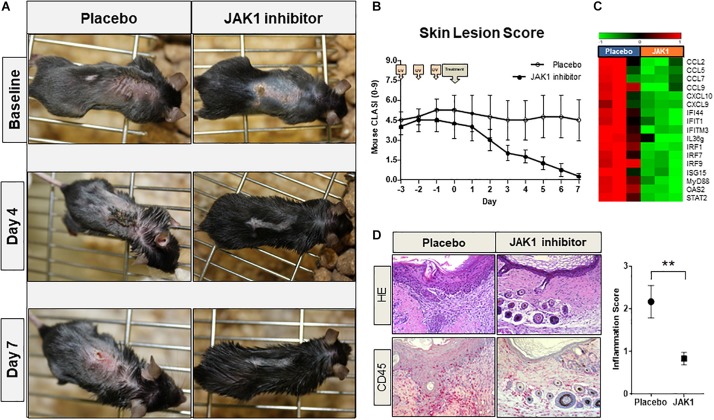
Pharmacological JAK1 inhibition in vivo in a lupus-prone TREX1–/– mouse model (using JAK1 inhibitor INCB039110). (A) Clinical findings of UV-stimulated (started on day -3; 3 × 450 mJ/cm2 for 115 s) TREX1–/– mice (n = 8) on baseline (day 0, start of treatment) and after 4 and 7 days of treatment with JAK1 selective INCB039110 or placebo. (B) Mean score of the mouse-adapted revised CLE-disease-area-and-severity index (Mouse RCLASI) ± SEM in n = 4 mice per group. (C) IFN-associated differentially expressed genes in lesional skin of TREX1–/– mice treated with a JAK1 inhibitor (JAK1) or placebo, showing a significant downregulation after JAK1 inhibitor treatment (>twofold, p < 0.05,Welch’s t-test). (D) Histological (H&E) and immunohistological (CD45) micrographs of lesional skin, original magnification ×400. Corresponding inflammation score of CD45 expression in lesional skin of placebo-treated and JAK1-inhibitor treated mice. All bars show mean ± SEM, ** =̂ p < 0.01 (Mann-Whitney U test).